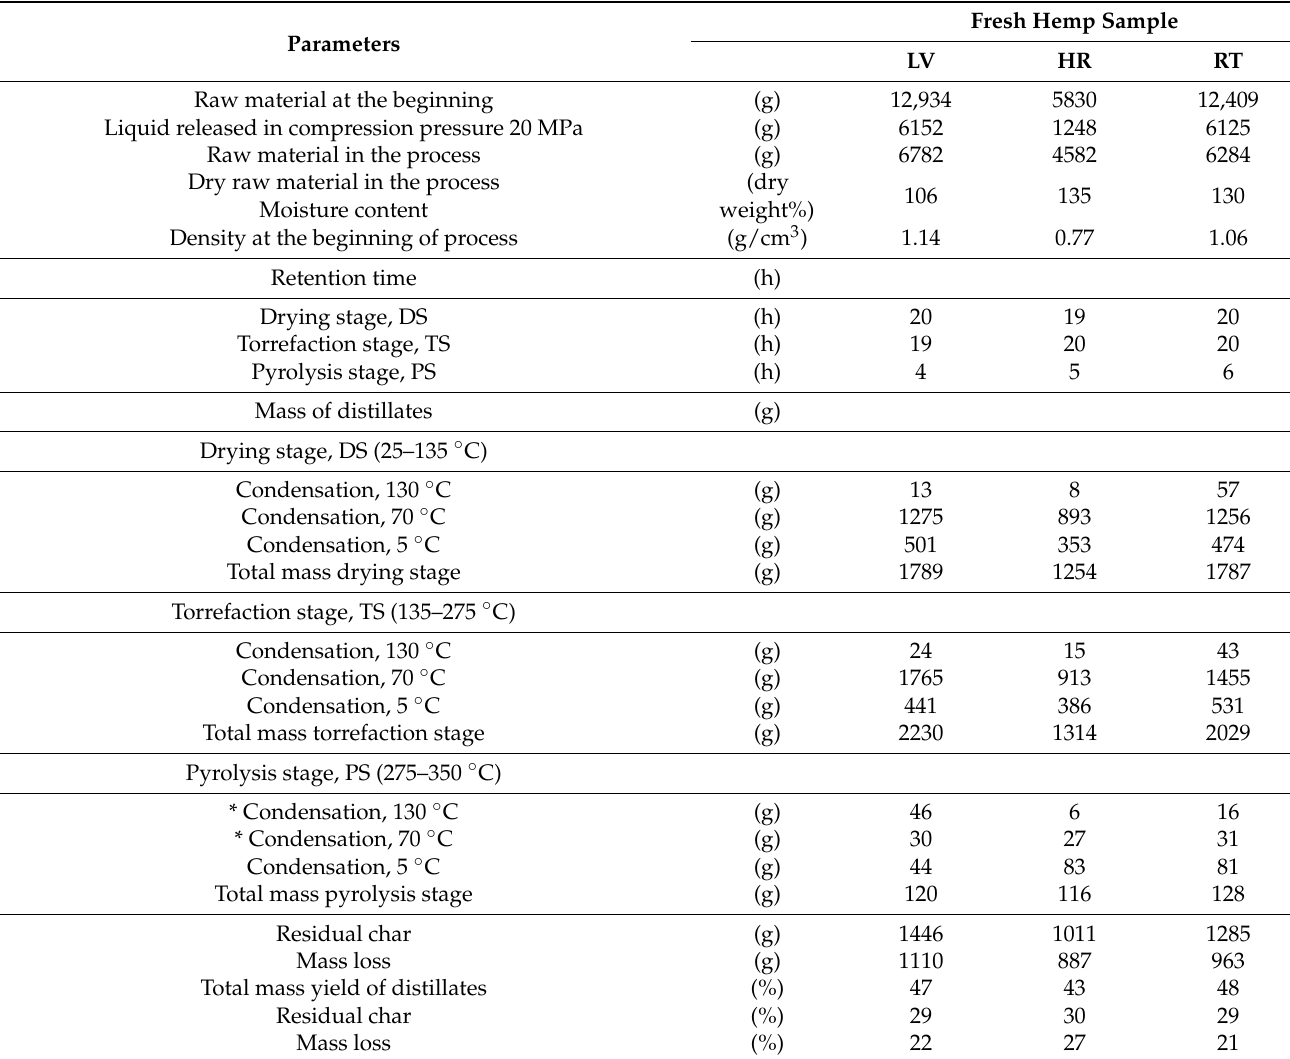
Table 1. Slow pyrolysis process runs and mass balance of